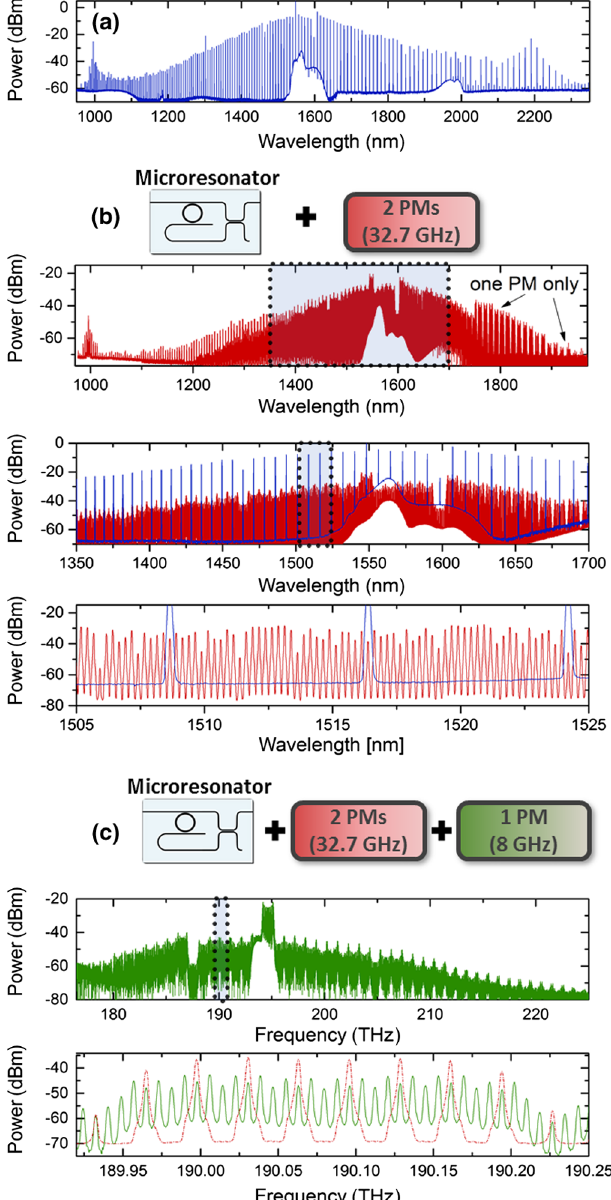
FIG. 3. Reduction of the 1-THz SiN microcomb mode spacing through EO phase modulation. (a) Microcomb spectrum coupled out of the SiN waveguide, using lensed fibers. (b) The full microcomb spectrum (blue) is sent through two low- V π electro- optic phase modulators (PM), which are driven at roughly = 31 ). These modulators are optimized for 32.7 GHz ( f repSiN operation at 1550 nm; however, they perform well over a relatively large bandwidth, and the resulting spectrum includes a filled-in 32.7-GHz comb that spans nearly 350 nm (red). (c) Demonstrating further reduction, we send the 32.7-GHz comb (red) through an additional PM driven at 8 GHz. The mode spacing of the resulting spectrum (green) has been divided by 124 from the original microcomb f . (This spectrum is shown in rep frequency units in contrast to the previous panels, shown in